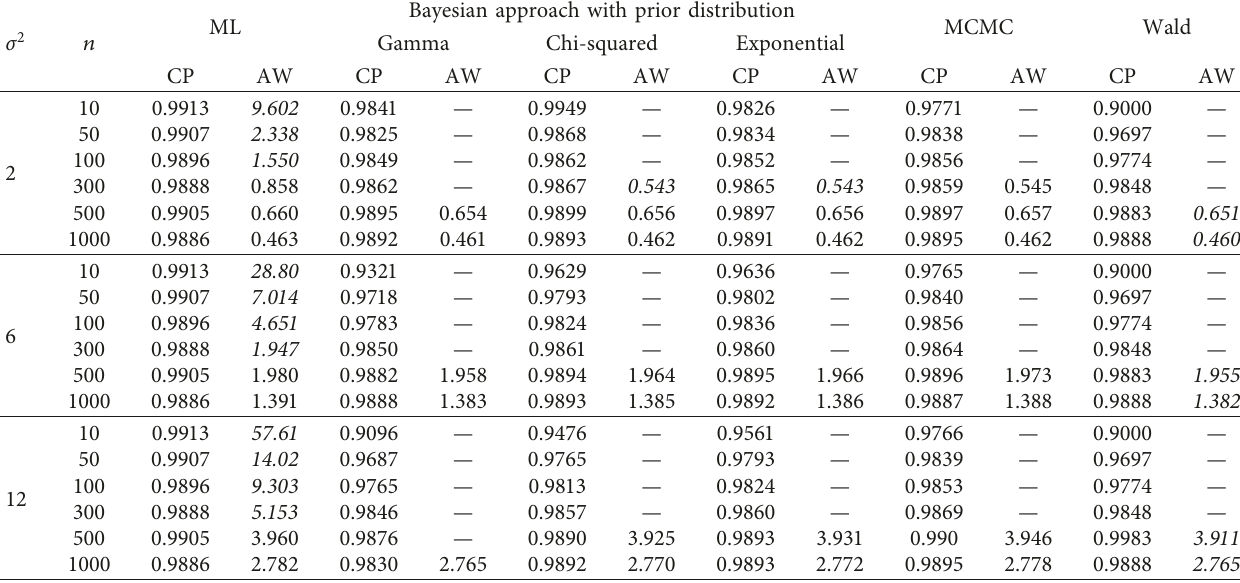
Table 4: The coverage probability (CP) and average width (AW) via 99% confidence